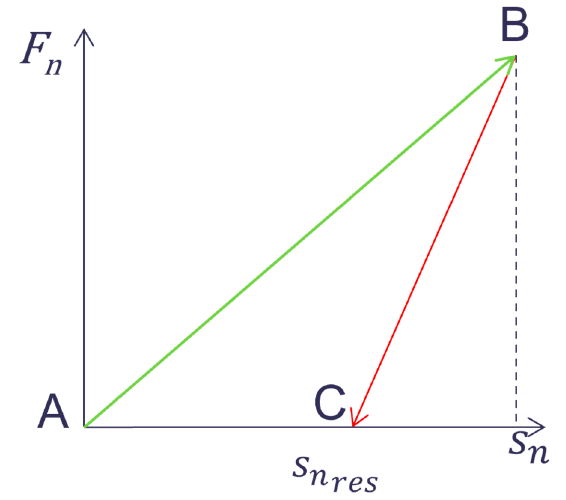
Figure 1. Overlap–normal force relationship in HLS model.